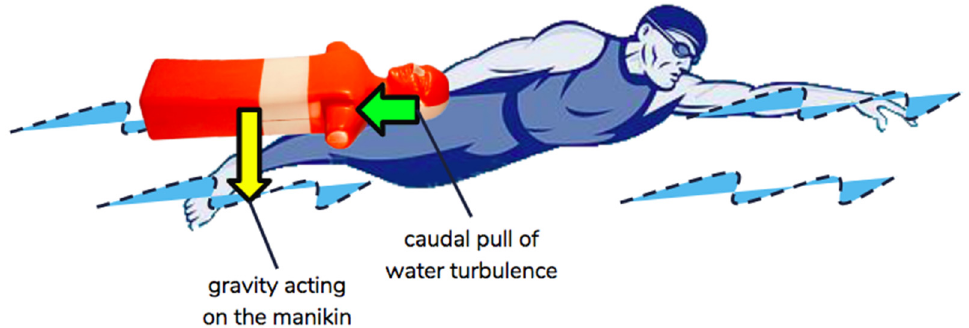
Figure 1. Two vector forces on the manikin during manikin carrying. Yellow arrow represents gravitational pull and green arrow represents caudal pull from the water turbulence.